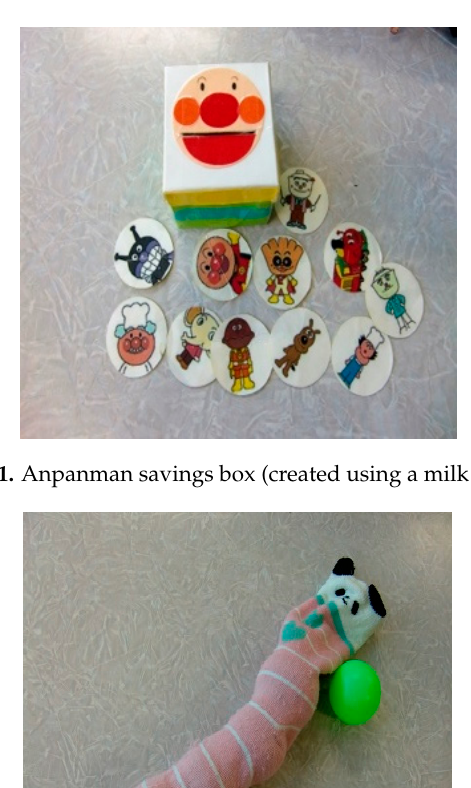
Figure 1: This handmade toy is a saving box shaped like Anpanman for children to enjoy touching original coins with various Anpanman characters drawn on and dropping them into the saving box. The coins with visually enjoyable drawings are also usable as cards.